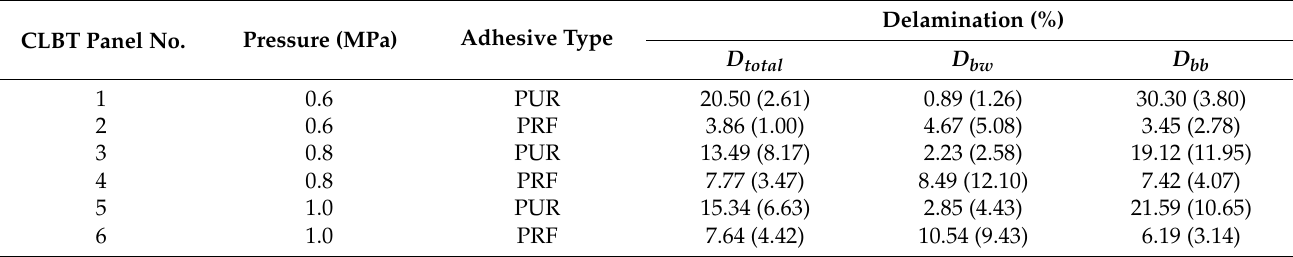
Table 5. Delamination test results of